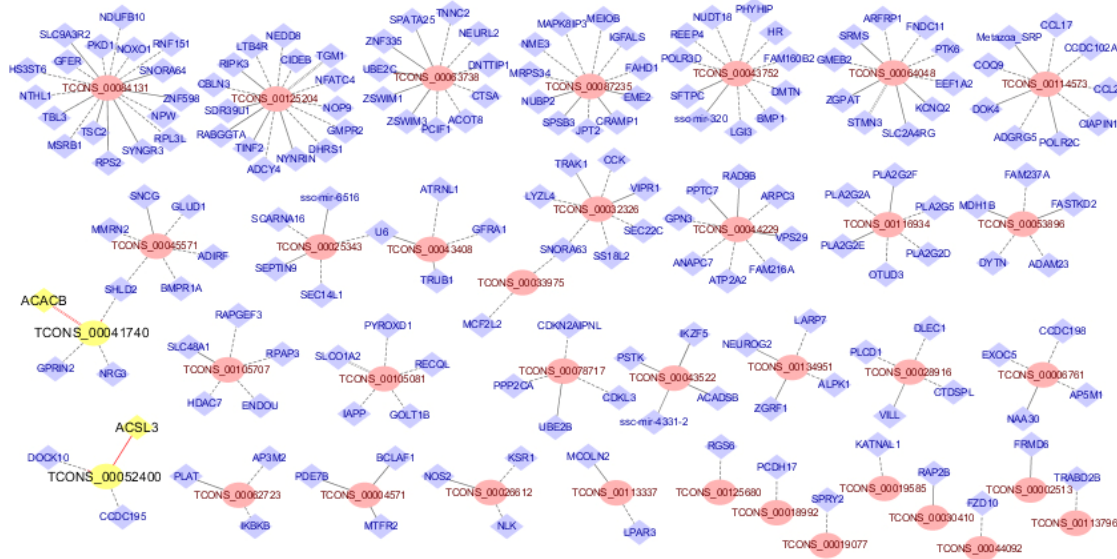
Figure 7. Network of regulatory relationships between differentially expressed long non-coding RNAs (DELs) and their target genes. DELs are indicated in red ovals; target genes are indicated in blue diamonds; the important long non-coding RNAs and genes are highlighted with yellow nodes and red labels. Cis-regulation is represented by a solid line, trans-regulation is represented by a dotted line, and dual-regulation is represented by a double line.